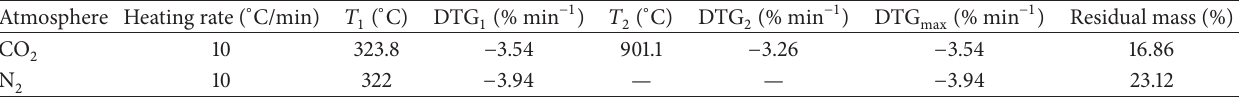
Table 2: Results from thermogravimetric analysis for Chlorella vulgaris in different atmospheres with the heating rate of 10 ∘ C/min.